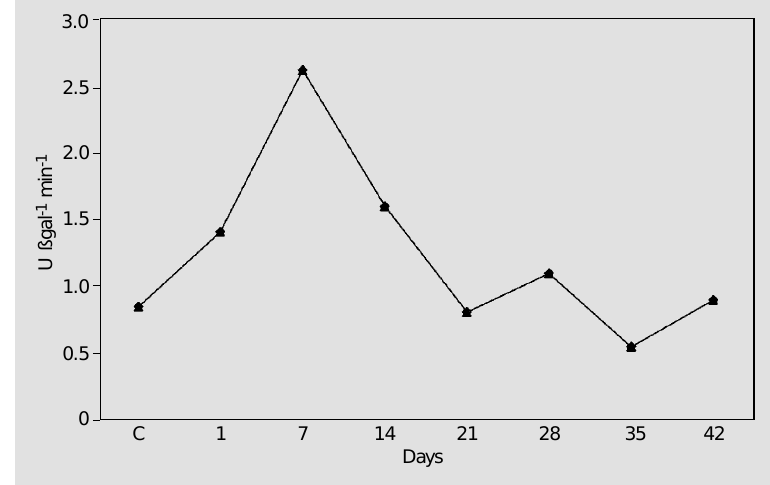
Figure 2 - Quantitative determination of ß-galactosidase gene expression following gene gun immunization with pCMV-ßgal. BALB/c mice (five per group) were vaccinated by the biolistic method with one shot per animal (below 0.5 µg of DNA) in the ear skin region. Every week after immunization ß-galactosidase activity was measured by a spectrophotometric assay using o-nitrophenol-ß-D-galactoside (ONPG). Results are reported as mean values of ß-galactosidase units (U/ßgal) over a period of time (in minutes). Units = (380 x A 420 ) divided by time, where 380 is a constant such that one unit is equivalent to conversion of one nanomole of ONPG per minute at 37 o C.